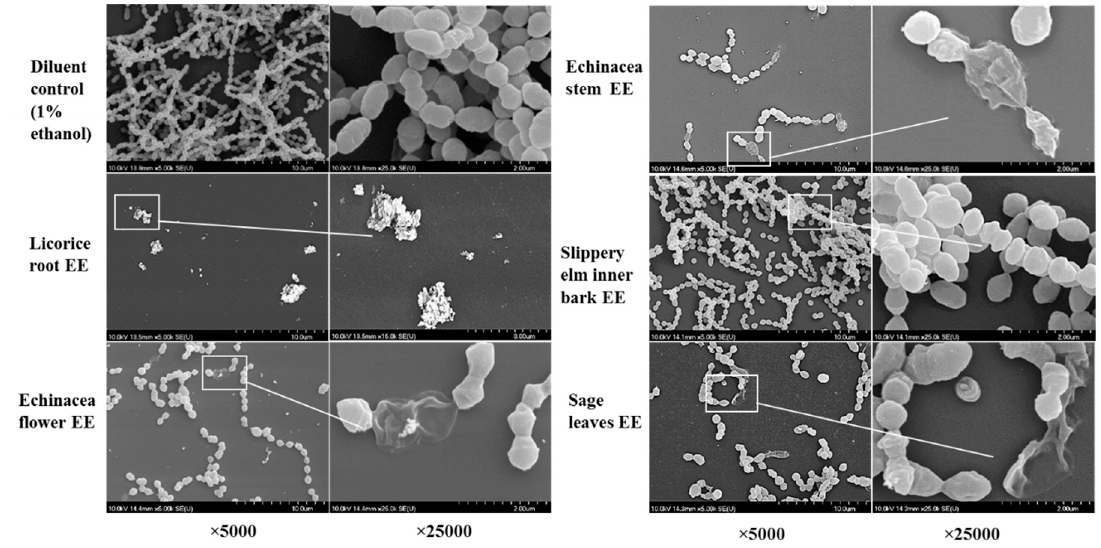
Figure 4. Scanning electron micrographs of Streptococcus pyogenes biofilms formed on the 96-well surface of sub-inhibitory concentrations of the ethanol extracts of licorice roots, purple coneflower flowers, purple coneflower stems, slippery elm inner barks, and sage leaves.